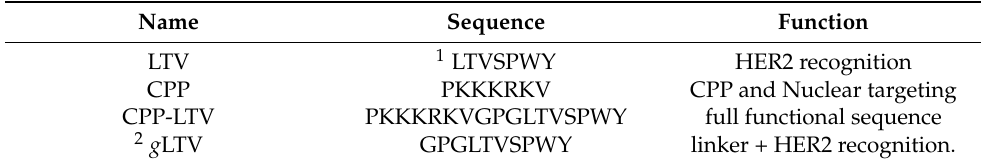
Table 1. List of peptide sequences used in this study. Name